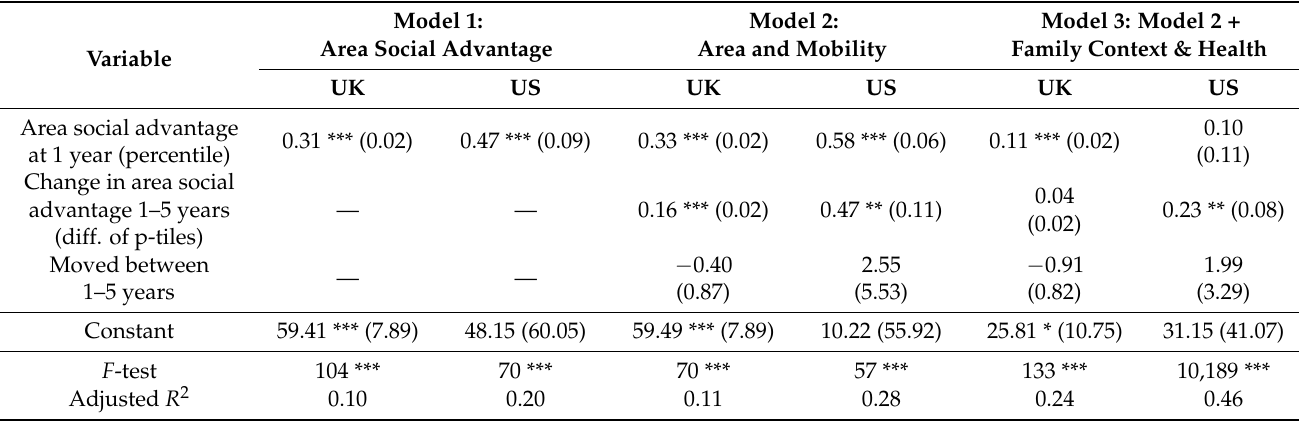
Table 2. Verbal Score at 5 years: Selected OLS Unstandardized Regressions Coefficients (Standard Error in parentheses) in UK (N = 7967) and US (N = 1458) a,b